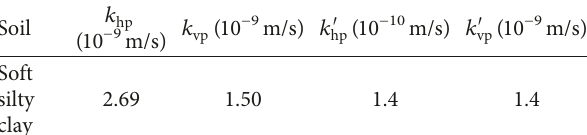
Table 3: Equivalent plane strain permeability of PVD improved soft clay.